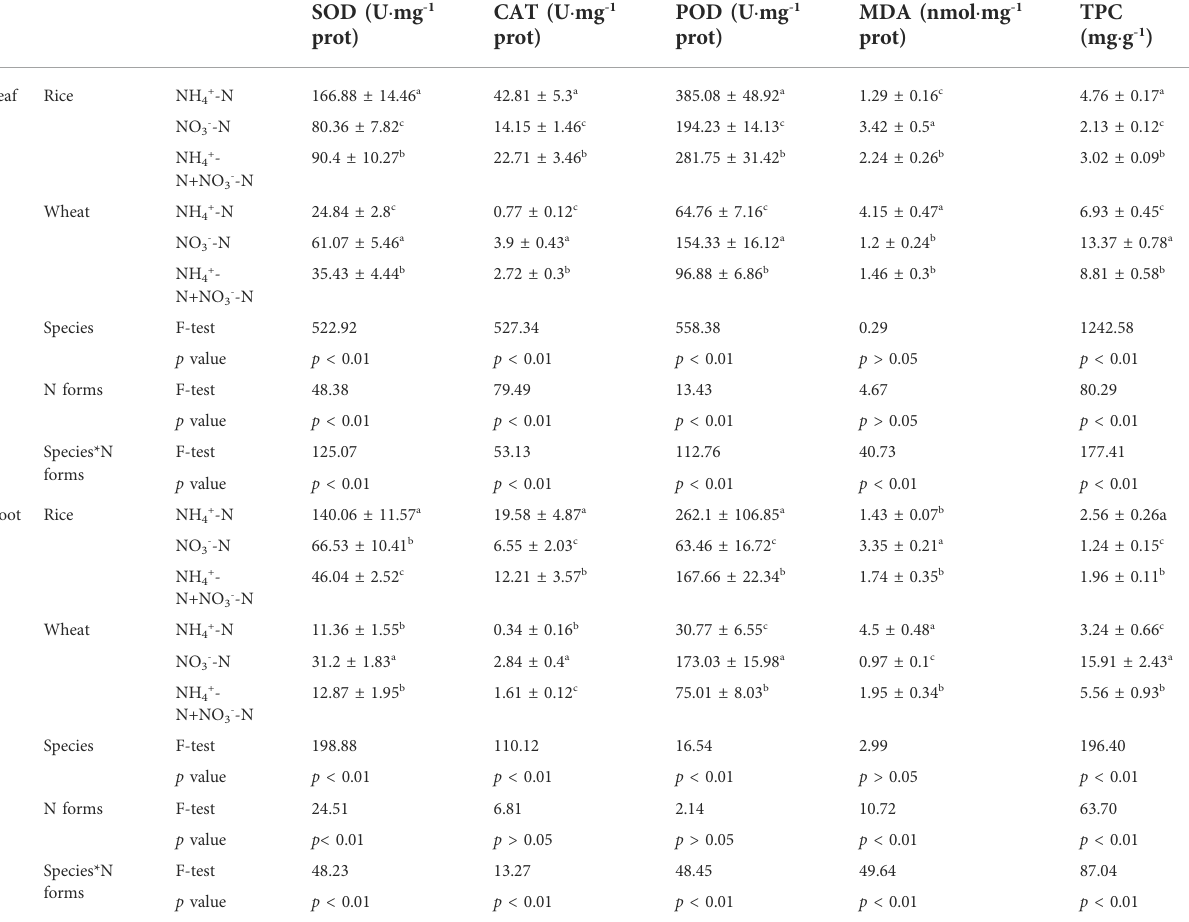
TABLE 2 Effect of different nitrogen forms on plant antioxidative enzymes activities, malondialdehyde and total protein